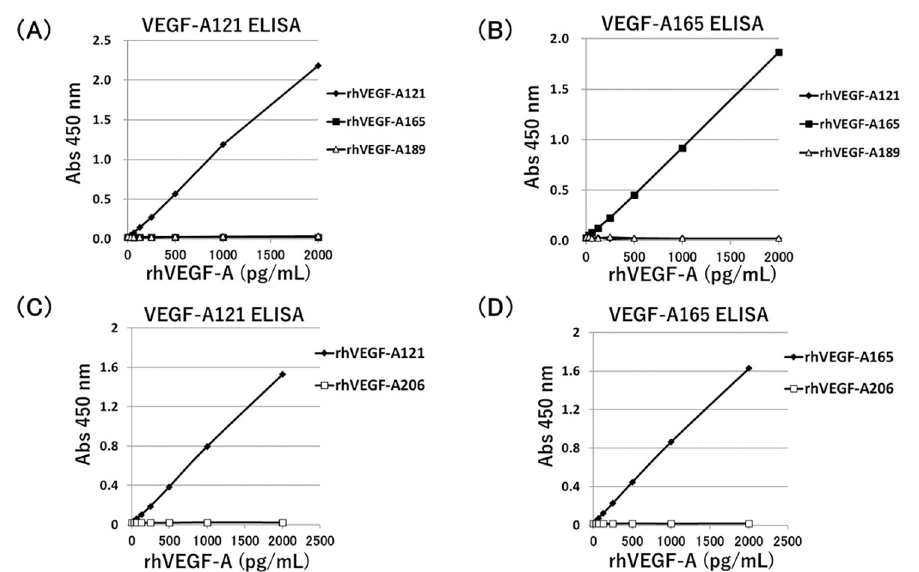
Fig 2. Specific immunoreactivity of the anti-VEGF-A121 and anti-VEGF-A165 monoclonal antibodies using for ELISA. The absorbance values at 450 nm (Abs 450 nm) obtained by VEGF-A121 ELISA (A, C) and VEGF-A165 ELISA (B, D). For these ELISAs, different doses of rhVEGF-A121, rhVEGF-A165, and rhVEGF-A189 (A, B) or rhVEGF-A206 (C, D) were evaluated. VEGF-A121 ELISA and VEGF-A165 ELISA specifically recognized rhVEGF-A121 (A, C) and rhVEGF-A165 (B, D), respectively.